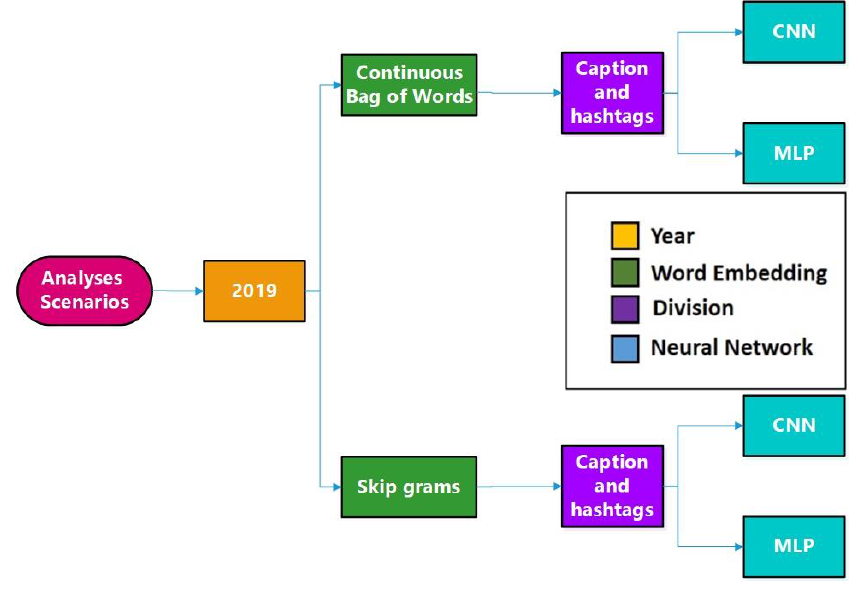
Figure 5 Analysis